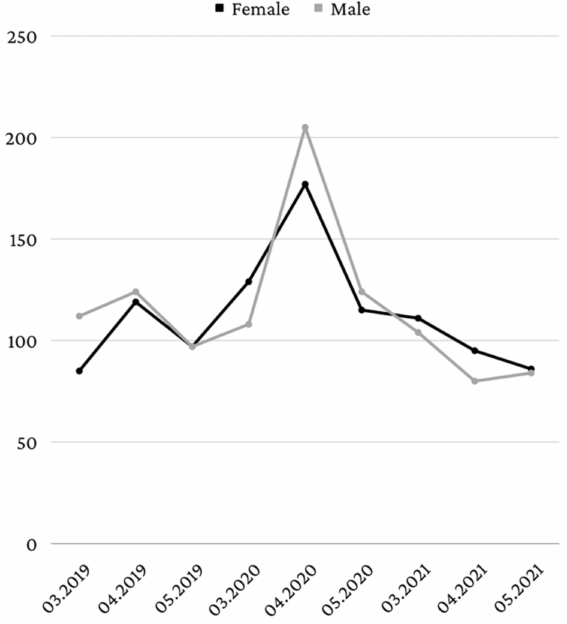
Figure 2. Distribution according to